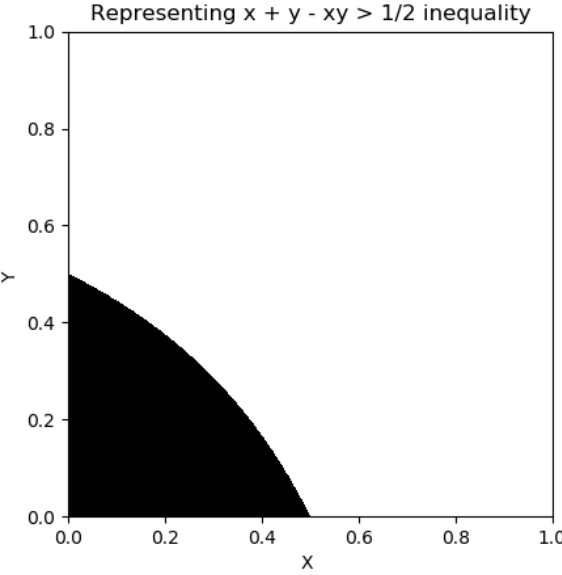
Figure 9. Graph representation of the formula x + y − xy = 1